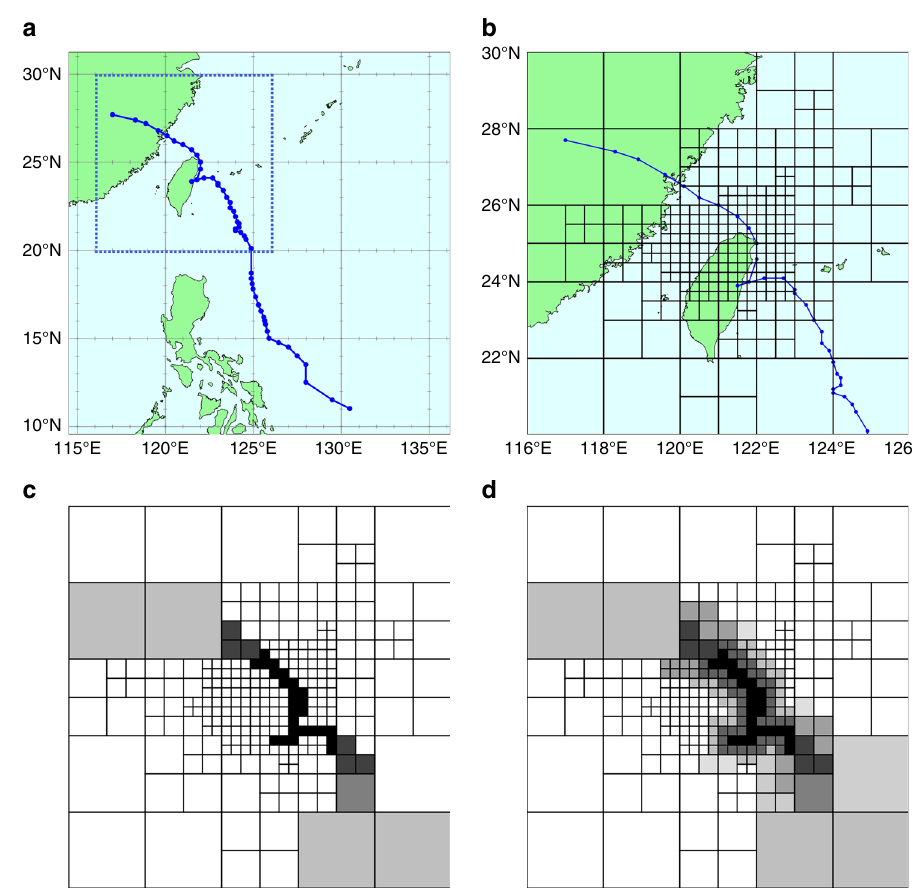
Fig. 1 Vectorization process of a typhoon track passing across Taiwan. a An example typhoon track passing over Taiwan. b An example typhoon track with the grid used to vectorize tracks. Variable size grid cells address topographic conditions (see Methods). c Each grid cell through which the typhoon moves is shaded. d To assess the spatial relationships of typhoon impacts, a weight diffusion process is applied to track plotting so that grid cells close to the typhoon track is also included, but with lower weights. The shade of each grid cell represents its weight (see